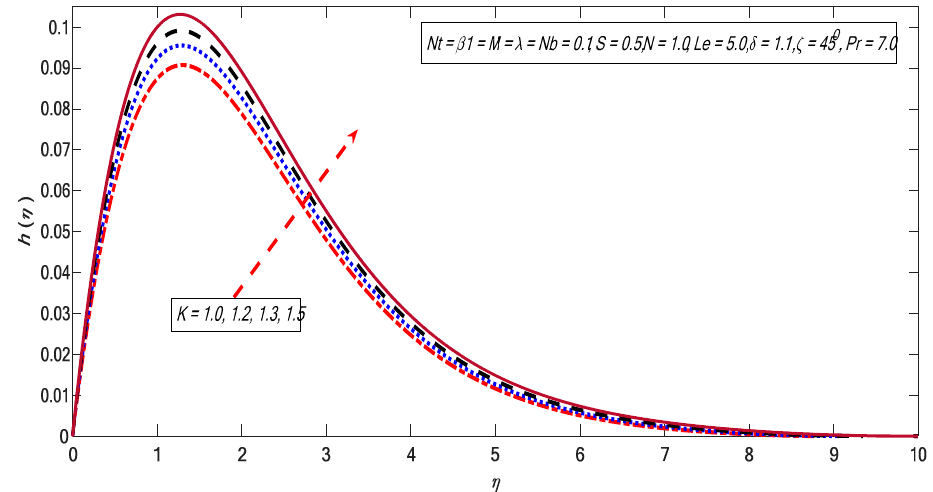
Figure 5. Variations in angular velocity profile for several values of 𝐾 .